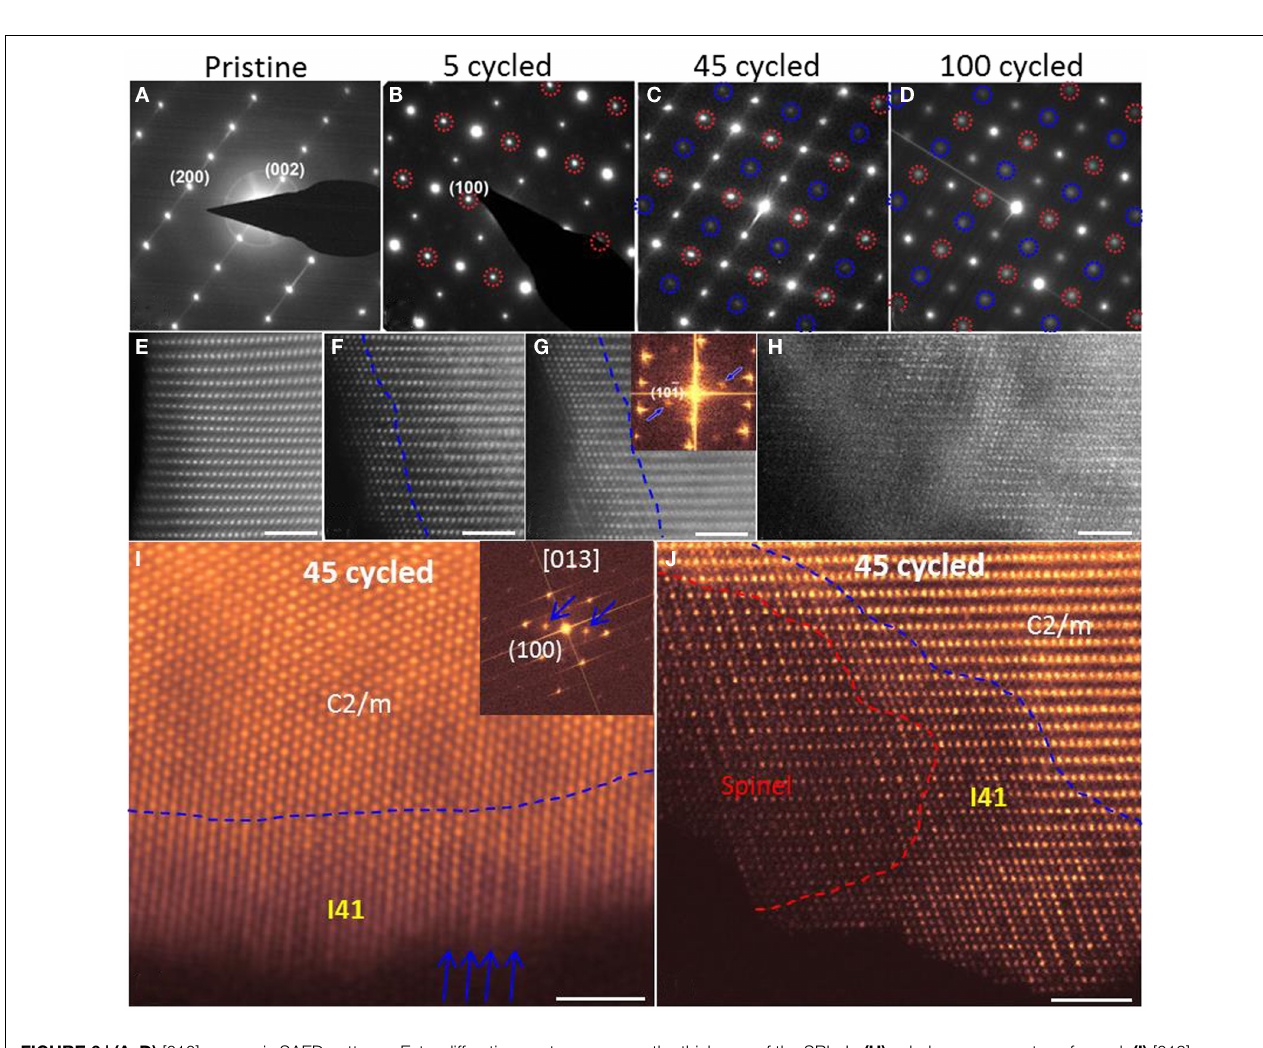
FIGURE 6 | (A–D) [010] zone axis SAED patterns. Extra diffraction spots appeared in cycled samples, which are highlighted by red and blue circles. Red circles indicate the formation of an ordered structure. The (100) ordered plane is clearly seen after cycling. Blue circles come from double diffraction. (E–H) High-resolution STEM-HAADF images that show the cycling-induced structure change on particle surfaces. Pristine samples (E) shows homogeneous structure from surface to bulk. Dashed lines in (F,G) highlight